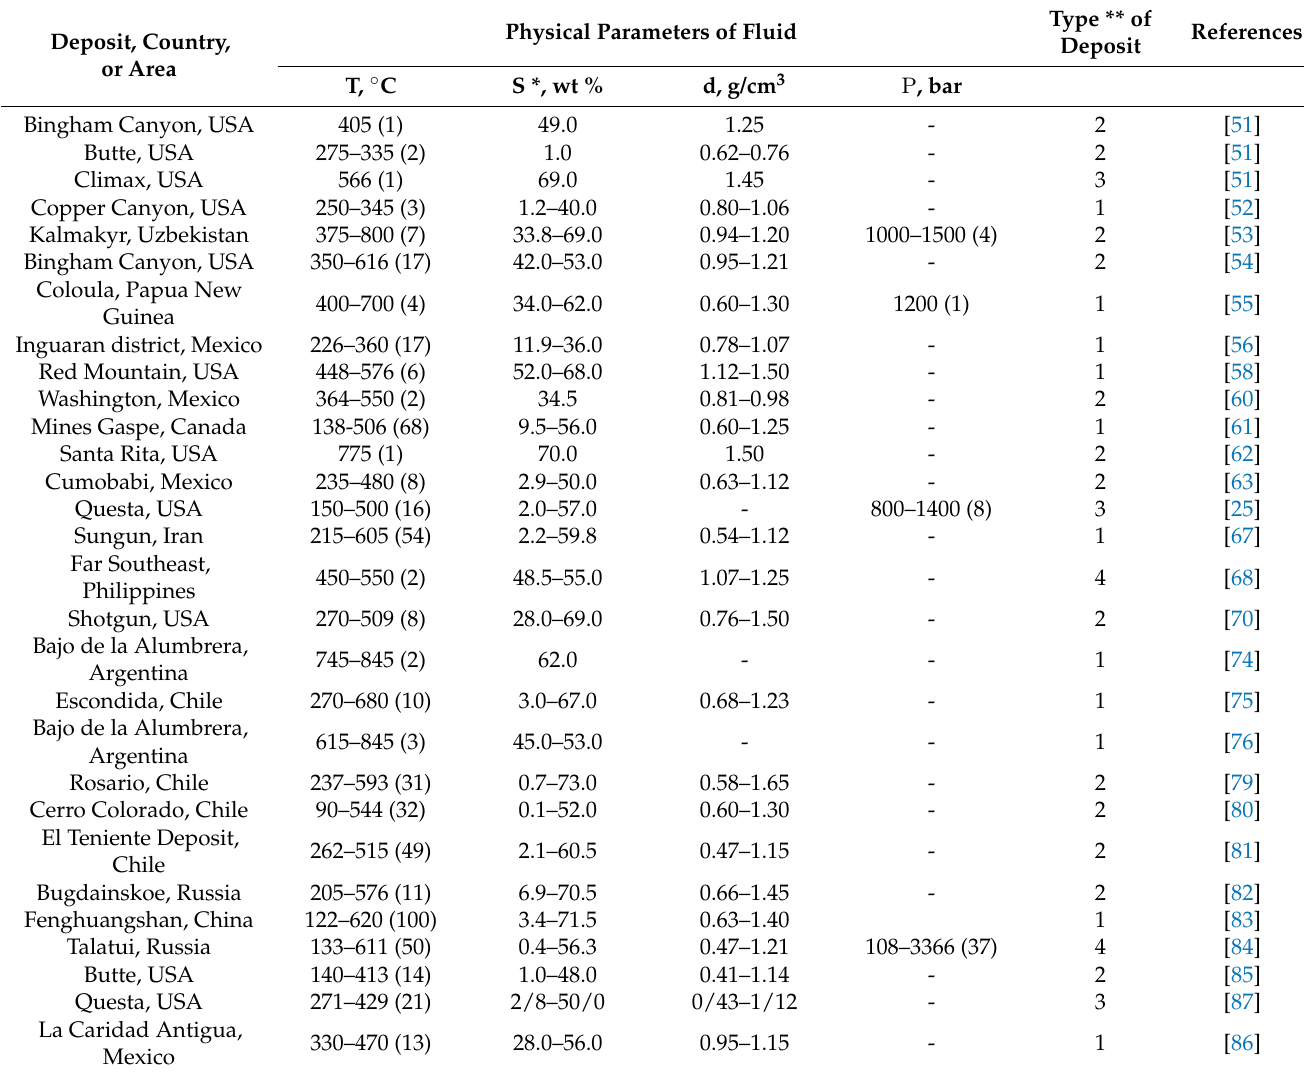
Table 2. Parameters of mineralizing fluids at porphyry